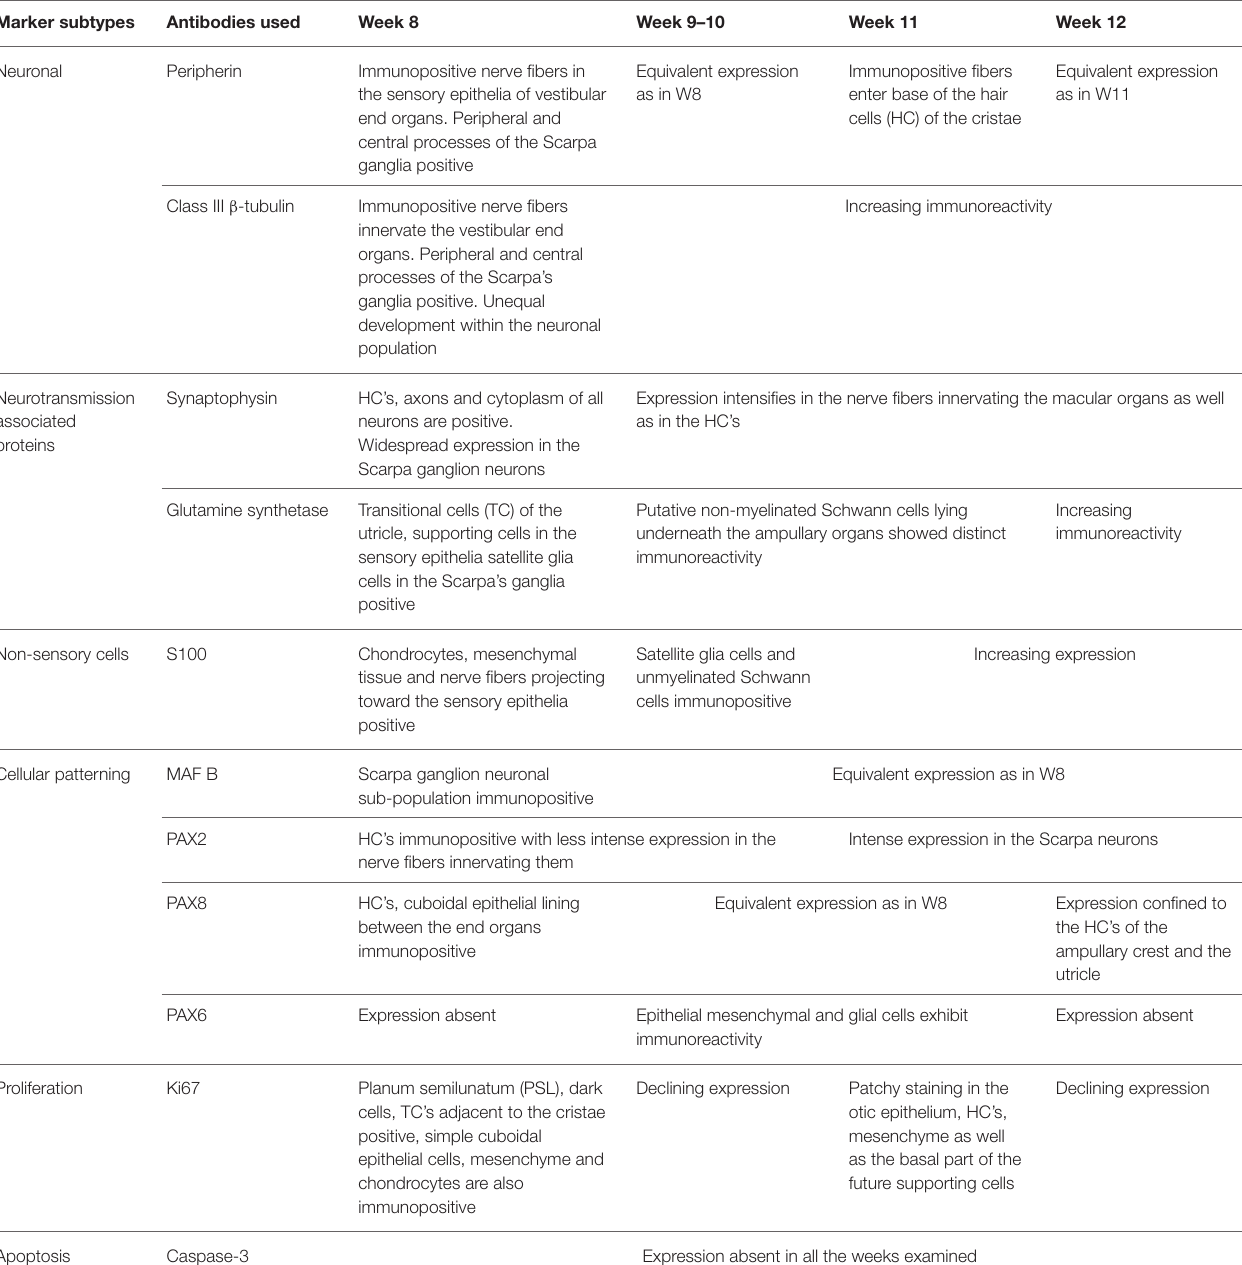
TABLE 2 | Summary of the expression timeline of selected markers in the development of the human inner ear between 8 and 12 weeks of gestation. Marker